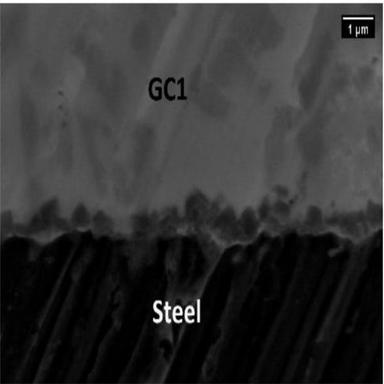
THG-5 joined sample tested at room temperature by glass-ceramic 1 (GC1): (a) polished cross-section; (b) typical fracture surfaces after torsion; (c) fracture propagation sketch (orange = glass-ceramic; grey = oxide scale; red = fracture propagation) showing the adhesive behavior, with glass-ceramic 1 (GC1) present on one fracture surface only, as observed in (d) by SEM-EDS, with each region identified (For interpretation of the references to colour in this figure legend, the reader is referred to the web v